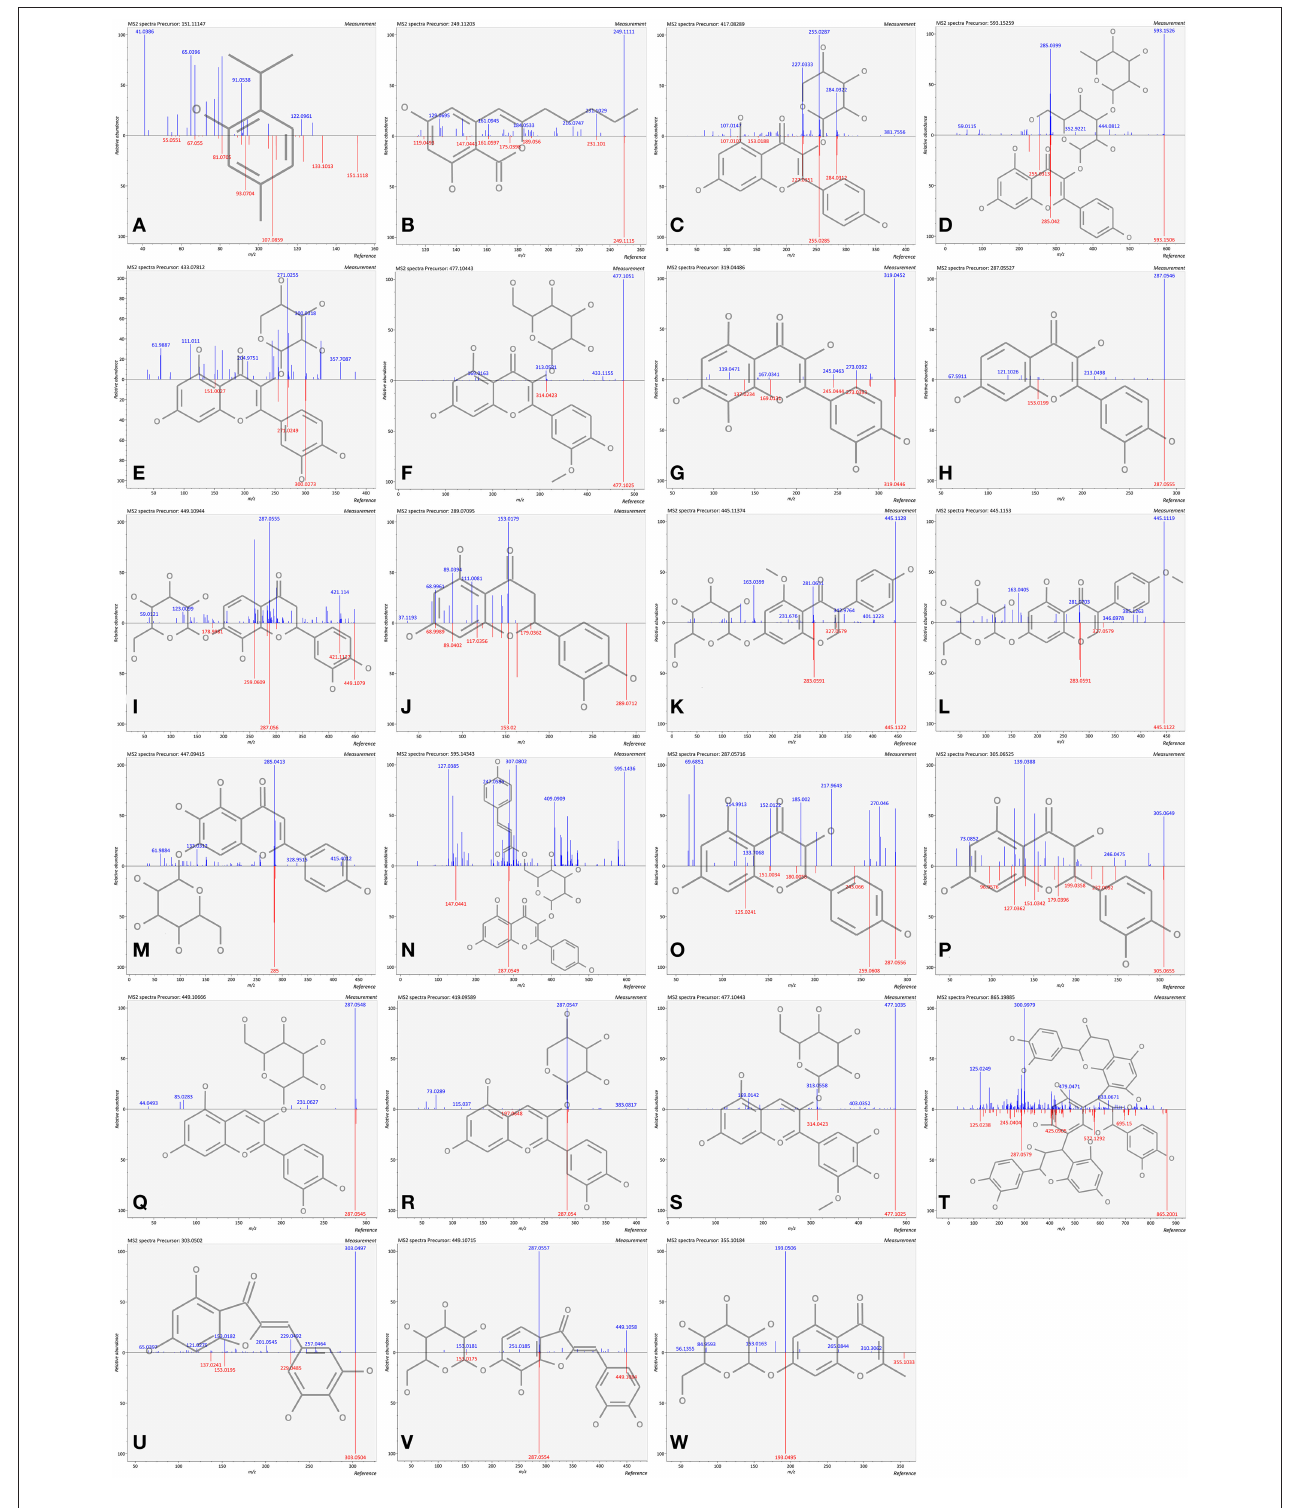
FIGURE 2 | Mirror images of firstly reported compounds in pomegranate peel. (A) thymol; (B) olivetonide; (C) kaempferol-3-O-arabinoside; (D) kaempferol-3-glucoside-3 ′′ -rhamnoside; (E) quercetin-3-O-xyloside; (F) isorhamnetin-3-galactoside; (G) gossypetin; (H) fisetin; (I) isookanin-7-O-glucoside; (J) eriodictyol; (K) isoprunetin-7-O-glucoside, (L) biochanin-7-O-glucoside; (M) plantaginin; (N) tiliroside; (O) dihydrokaempferol; (P) taxifolin; (Q) cyanidin-3-O-galactoside; (R) cyanidin-3-O-alpha-arabinoside; (S) petunidin 3-galactoside; (T) procyanidin C1; (U) bracteatin; (V) maritimetin-6-O-glucoside; (W) undulatoside